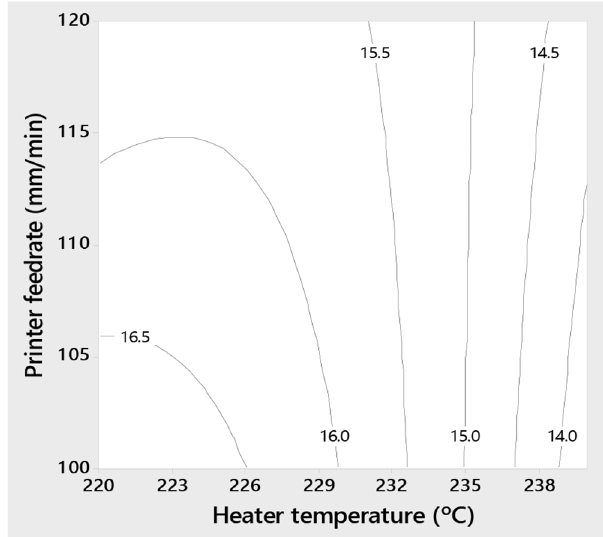
Fig. 13. Contour plot of fatigue strength versus heater temperature and heater feed rate.